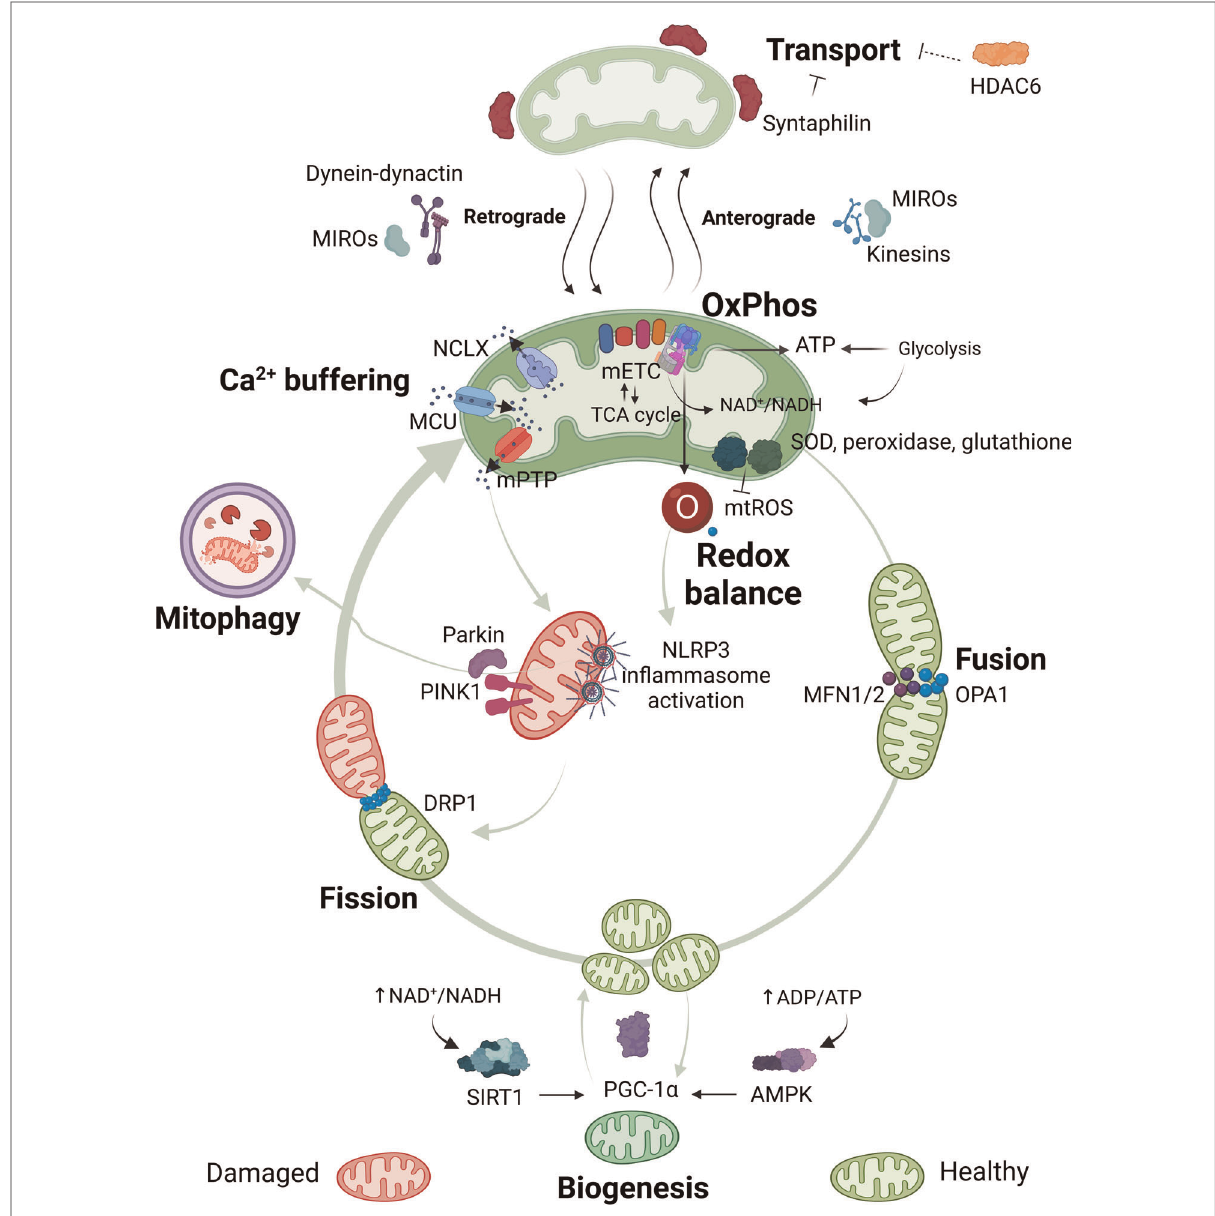
FIGURE 1 Overview of mitochondrial functions. Mitochondria are pleiotropic organelles with multiple functions. The most relevant ones are depicted in the fi gure. Mitochondria produce ATP via oxidative phosphorylation (OxPhos), which involves the interaction between the mitochondrial electron transport chain (mETC) and enzymes from the tricarboxylic acid (TCA) cycle. The mETC is the main source of mtROS, which are eliminated by mitochondrial antioxidant enzymes like superoxide dismutase (SOD), peroxidase or glutathione. Ca 2+ enters the mitochondria through the mitochondrial Ca 2+ uniporter (MCU) and is released through the Na + /Ca 2+ exchanger (NCLX), or in case of Ca 2+ overload in the mitochondrial matrix through assembly of the mitochondrial permeability transition pore (mPTP). Increased mtROS production or mitochondrial Ca 2+ concentration can trigger nucleotide-binding oligomerization domain-like receptor pyrin domain containing 3 (NLRP3) in fl ammasome activation and/or binding of Parkin and PTEN-induced kinase 1 (PINK1) to mitochondria, which leads to the elimination of damaged mitochondria via mitophagy. Quality control mechanisms, such as mitophagy, fusion, fi ssion and biogenesis ensure a healthy and functional mitochondria pool. Optic atrophy 1 (OPA1) and mitofusins1 and 2 (MFN1 or MFN2) allow mitochondria to merge (fusion), while dynamin-related protein (DRP1) permits mitochondria to segment ( fi ssion). New mitochondria are produced through biogenesis, which is promoted by peroxisome proliferator- activated receptor gamma coactivator 1-alpha (PGC-1 α ). Decreased energy production detected by energy sensors sirtuin1 (SIRT1) and adenosine monophosphate (AMP)-activated protein kinase (AMPK) will activate PGC-1 α . Quality control mechanisms are highly dynamic and adapt to the cells ’ needs. Mitochondria are transported to the area where they are required. In neurons, mitochondria travel from the soma to the axons and damaged mitochondria back to the soma. Anterograde transport of mitochondria is mediated by mitochondrial Rho GTPases (MIROs) and kinesins, whilst retrograde transport is mediated by MIROs and dynein-dynactin complexes. Syntaphilin is an anchor protein that stabilizes mitochondria in a fi xed spot. Histone deacetylase 6 (HDAC6) indirectly reduces mitochondrial transport by deacetylation of the cytoskeletal α - tubulin, a protein that facilitates dynein-dependent mitochondrial transport when acetylated. Figure created with